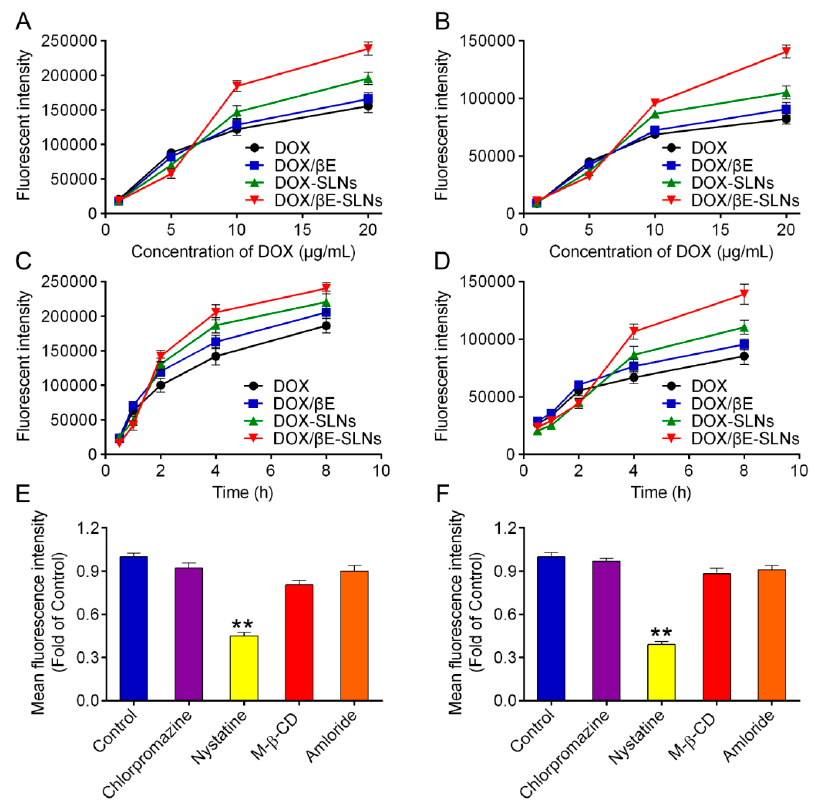
Figure 3. ( A , B ) Uptake of DOX, DOX/ β E, DOX-SLNs, and DOX/ β E-SLNs into K562 cells ( A ) and K562 / DOX cells ( B ) when treated with di ff erent concentration of DOX for 4 h. ( C , D ) Uptake of DOX, K562/DOX cells ( B ) when treated with different concentration of DOX for 4 h. ( C , D ) Uptake of DOX, DOX / β E, DOX-SLNs, and DOX / β E-SLNs into K562 cells ( C ) and K562 / DOX cells ( D ) at di ff erent time DOX/ β E, DOX-SLNs, and DOX/ β E-SLNs into K562 cells ( C ) and K562/DOX cells ( D ) at different time points. ( E , F ) The internalization mechanism for DOX / β E-SLNs in K562 cells ( E ) and K562 / DOX cells ( F ) points. ( E , F ) The internalization mechanism for DOX/ β E-SLNs in K562 cells ( E ) and K562/DOX cells ( F ) after treating with different inhibitors. Measurements were performed in triplicate. Data after treating with di ff erent inhibitors. Measurements were performed in triplicate. Data represent represent means ± SD ( n = 3). ** p < 0.01 versus control group. means ± SD ( n = 3). ** p < 0.01 versus control